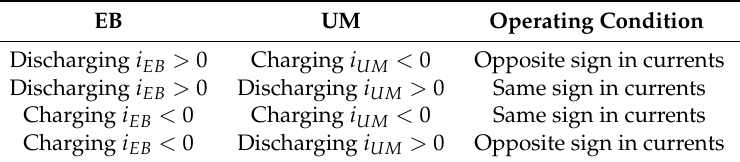
Table 4. Operating conditions of storage systems, considering references in Figure